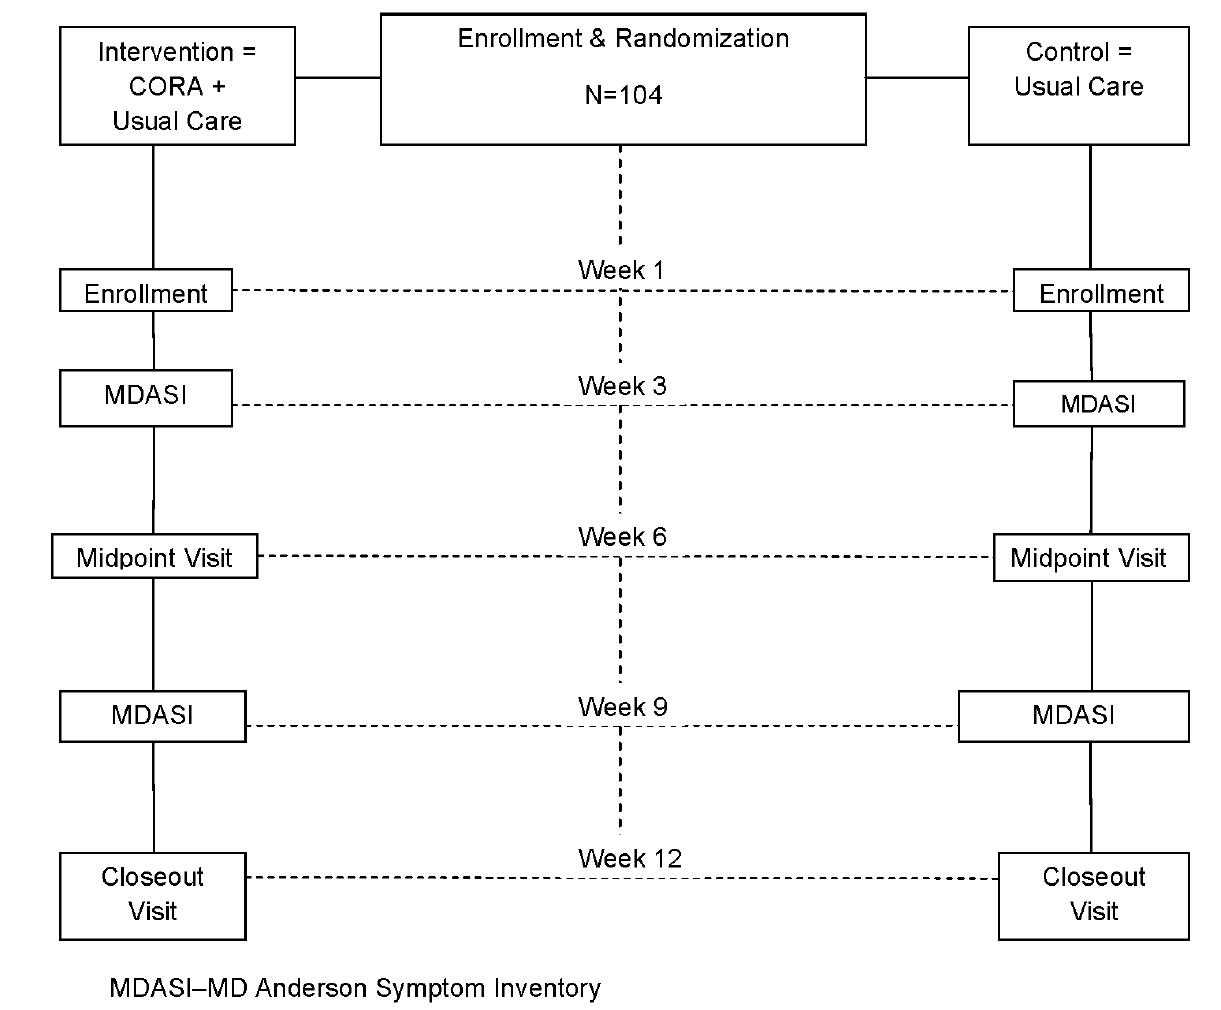
Figure 1. Schematic summary of the trial